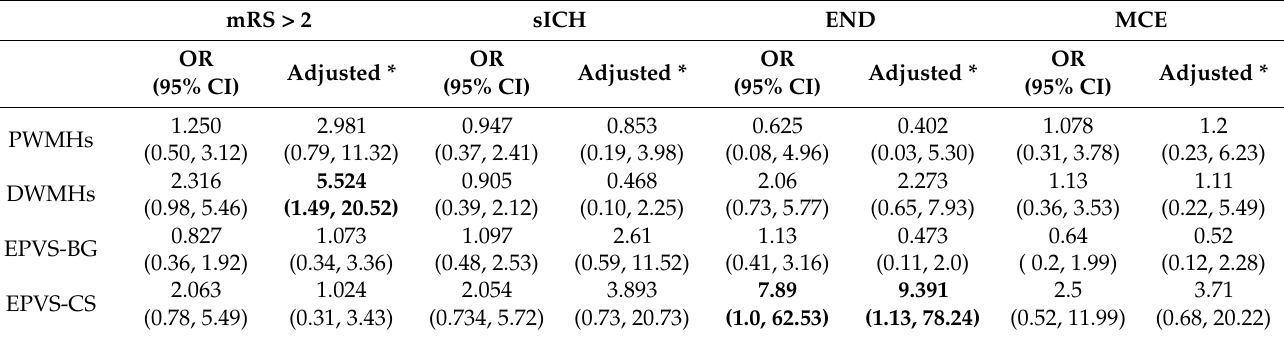
Table 4. Associations between individual CVSD imaging markers and outcomes by logistic